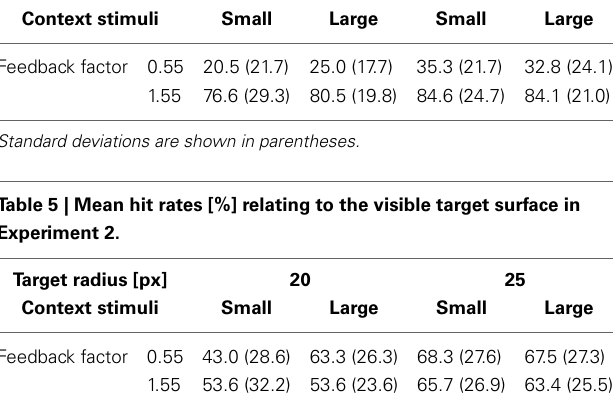
FIGURE 3 | Schematic illustration of the critical manipulation (upper part) and of the main trial events in Experiment 2 (lower part).